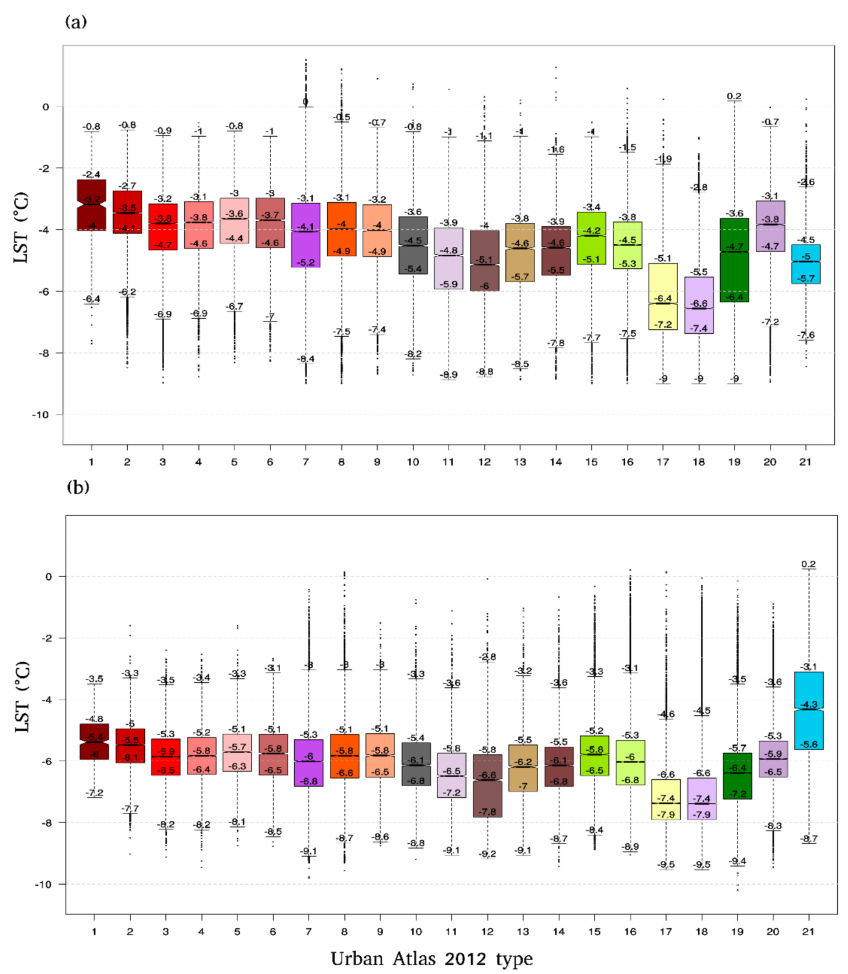
Figure 8. Statistic of land surface temperature in Pozna´n (( a )—9 February 2010, ( b )—21 February 2011) based on Landsat images according to Urban Atlas 2012 types (colors and order of types according to legend in Figure 1). On the boxplot, the middle values denote medians, the box extends to the Q1 (first quartile) and Q3 (third quartile), and the whiskers show the range (99.3%): the upper whisker shows Q3 + 1.5 × IQR (the interquartile range), the lower shows Q1 − 1.5 × IQR. The notches extend to ± 1.58 IQR/sqrt(n) and the dots represent